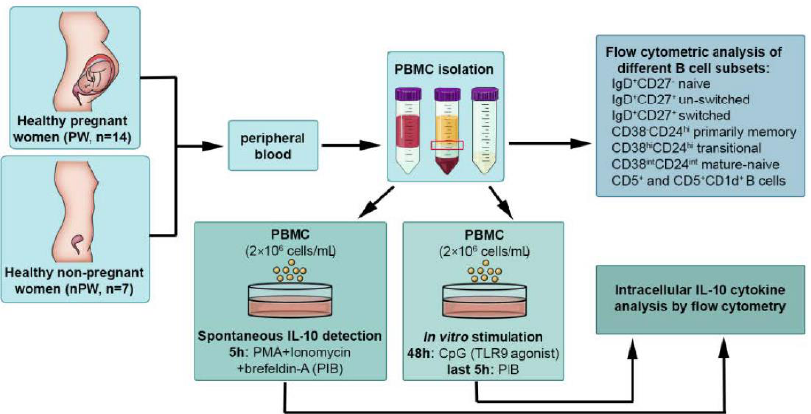
Figure 1. Flowchart demonstrating the study design and detailing the procedure of analyzing different B cell subsets and IL-10-producing cells by flow cytometry in healthy pregnant and non-pregnant women. PBMC, peripheral blood mononuclear cell.